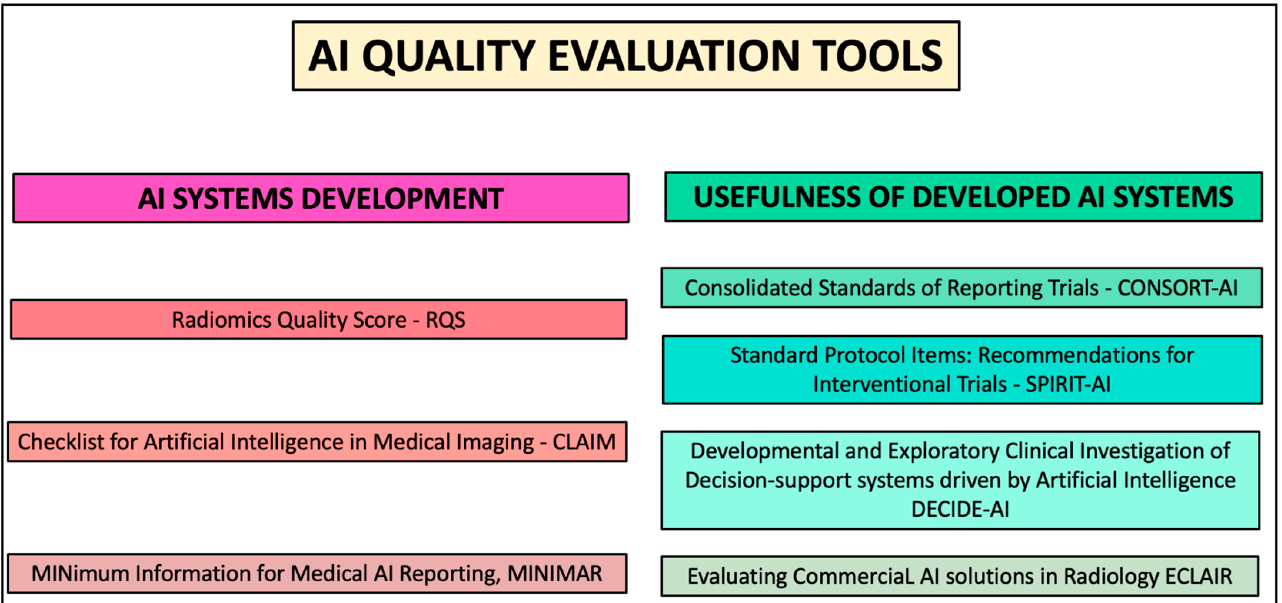
Figure 4. An overview of the main AI quality evaluation tools.